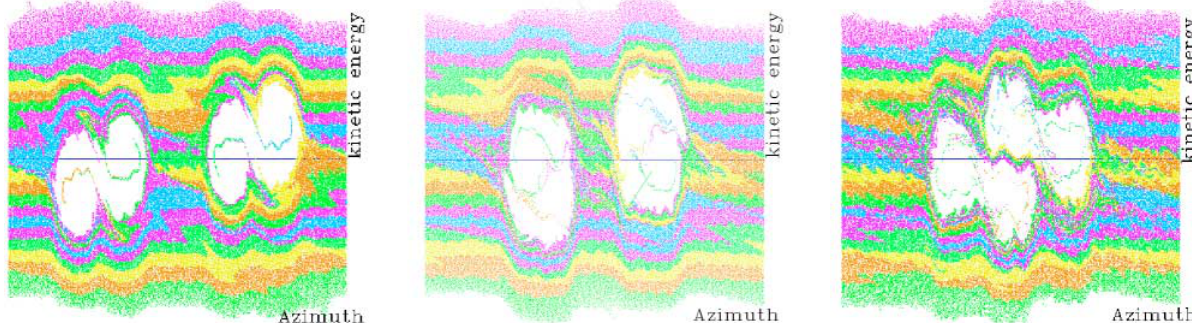
FIG. 31. (Color) Phase space scatter plots (left to right) at 2 14.62 , 2 14.37 , and 2 14.12 ms, respectively. 10 13